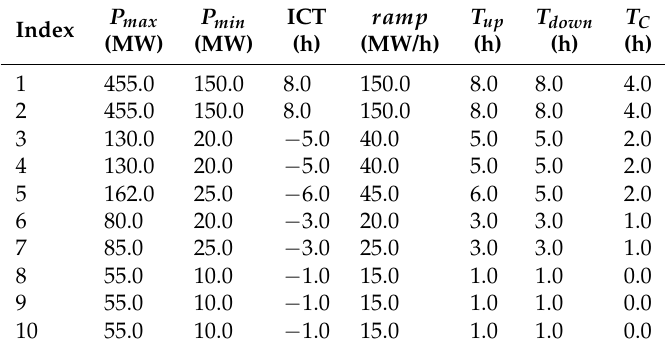
Table A1. 10 units system operation data.